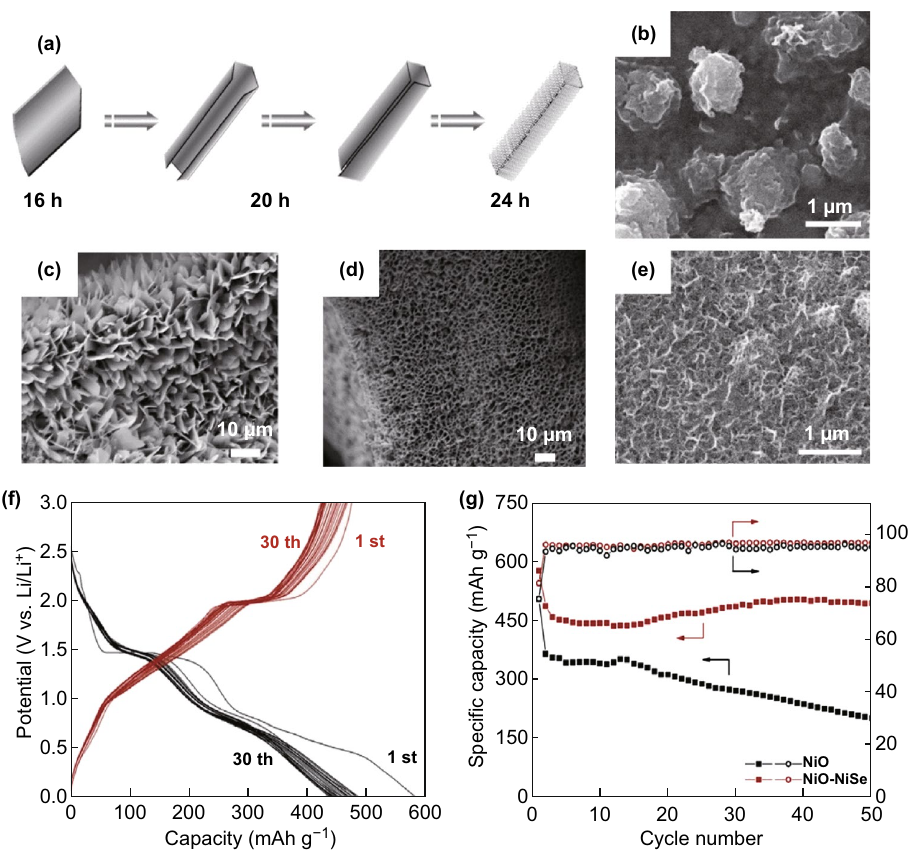
Fig. 4 a Schematic diagram of the morphology evolution of nickel grown in situ on foamed nickel. b SEM image of NiO–NiSe electrode after initially discharging to 0.01 V. c Schematic diagram of the morphology evolution of nickel crystal grown in situ on foamed nickel with a reaction time of 16 h. d Schematic diagram of the morphology evolution of nickel crystal grown in situ on foamed nickel with a reaction time of 20 h. e SEM image of NiO–NiSe electrode after initially charging to 3.0 V. f At a current density of 20 mA g −1 , the initial discharge and charge and dis- charge curves of the NiO–NiSe electrode in the voltage range of 0.1–3.0 V were 30. g Cycling performance of NiO–NiSe thin film electrode for the initial 50 cycles. Adapted from Refs. [46, 47] with permission. Copyrights: 2012, Royal Society of Chemistry and 2015,